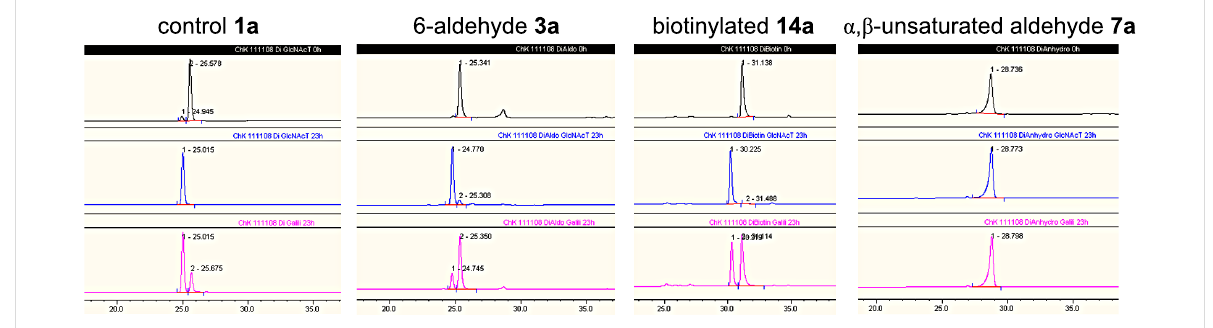
Figure 2: HPLC analysis for the conversion of modified LacNAc oligomers 3a, 15a , and 7a with β 3-GlcNAc-transferase and MBP-His 6 - α 3Gal-trans- ferase. LacNAc–linker– t- Boc 1a served as control. The upper panel (black) shows the substrates under the initial reaction conditions. The middle panel (blue) depicts the conversion with β 3-GlcNAc-transferase after 23 h and the lower panel (magenta) the conversion with MBP-His 6 - α 3Gal-trans- ferase after 23 h. The 6-aldehyde of LacNAc ( 3a ) and the C6-biotinylated LacNAc ( 15a ) are substrates for enzymatic elongation, while the α , β - unsaturated aldehyde derivative of LacNAc ( 7a ) is not accepted by either glycosyltransferase.